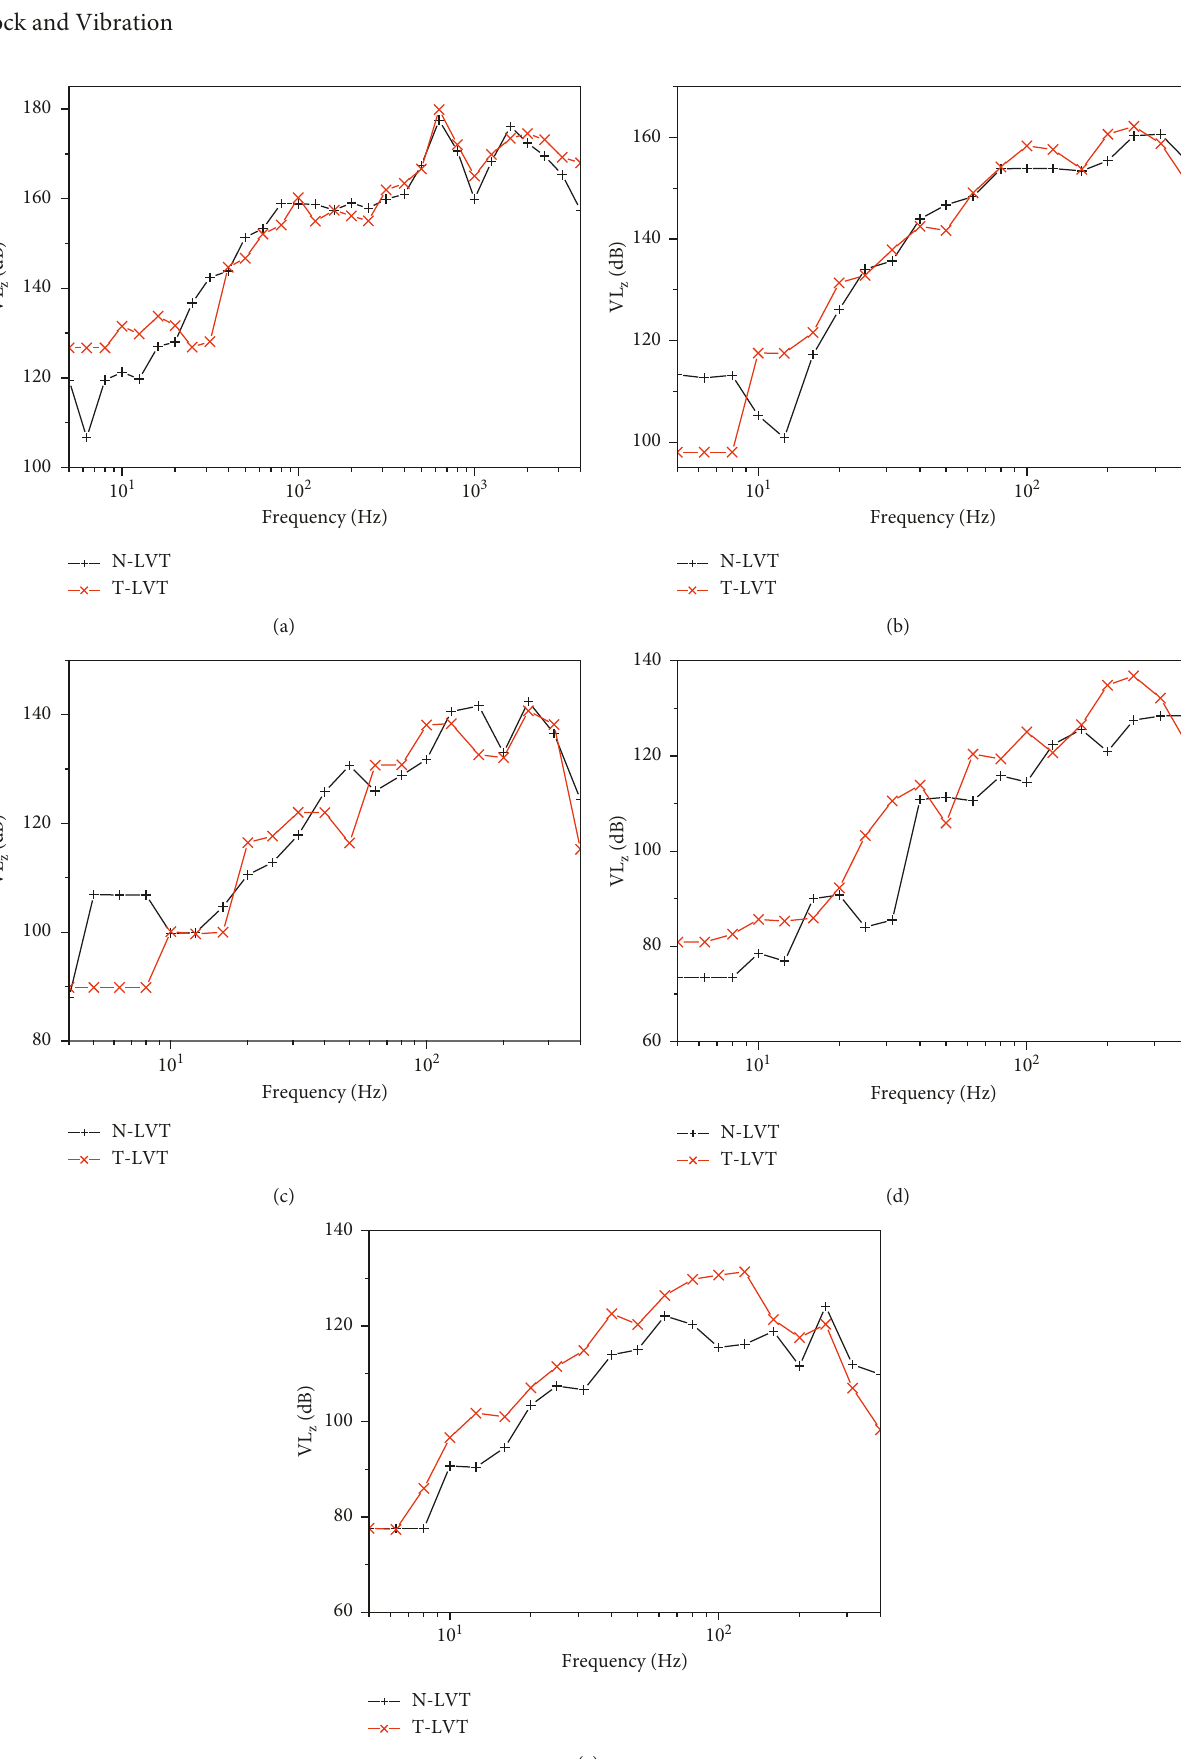
Figure 14: 1/3 octave curve of the track components. (a) Rail. (b) Bearing block. (c) Track slab. (d) Foundation base. (e)